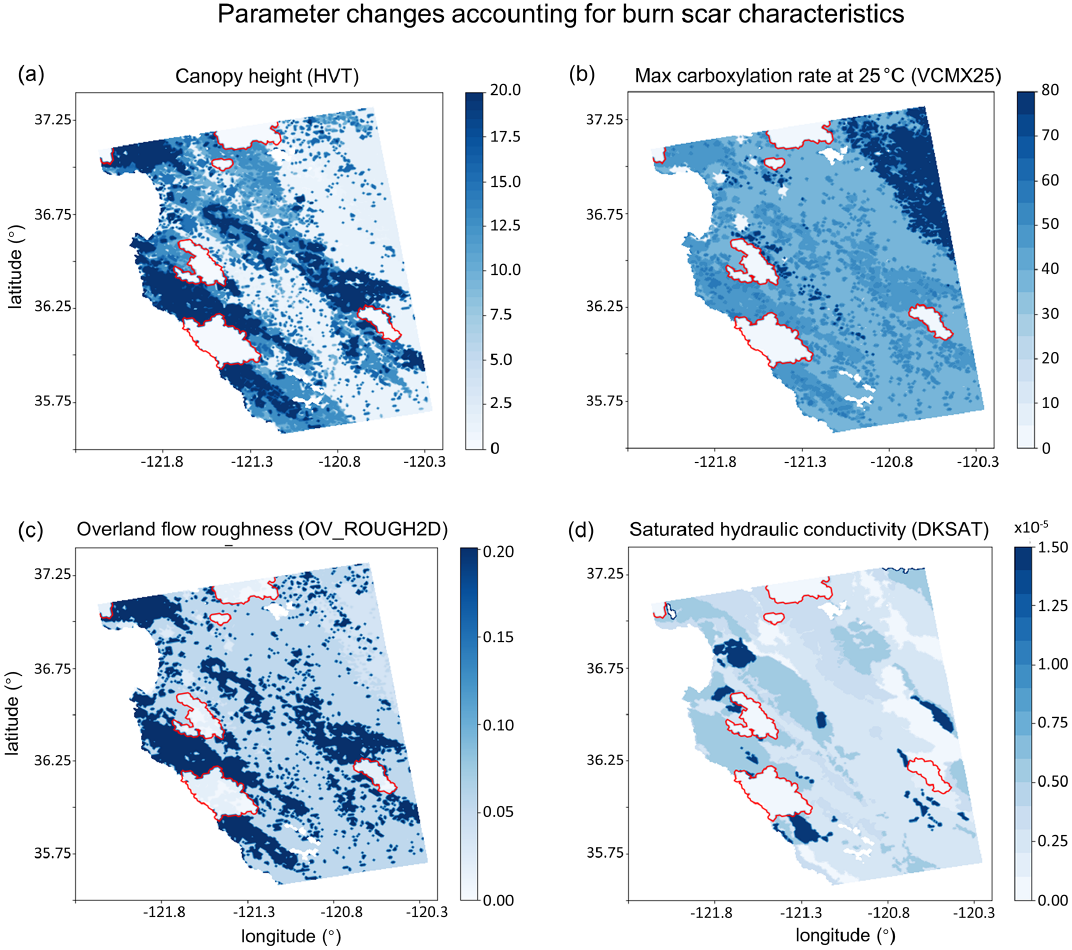
Figure 5. Parameter setting in the WRF-Hydro burn scar simulation. (a) The height of the canopy (HVT; m; shading), (b) maximum rate of carboxylation at 25 ◦ C (VCMX25; µmolCO 2 m − 2 s − 1 ; shading), (c) overland flow roughness coefficient (OV_ROUGH2D; shading), and (d) saturated hydraulic conductivity (DKSAT; ms − 1 ; shading) in the burn scar simulation. Burn scar perimeters are outlined in